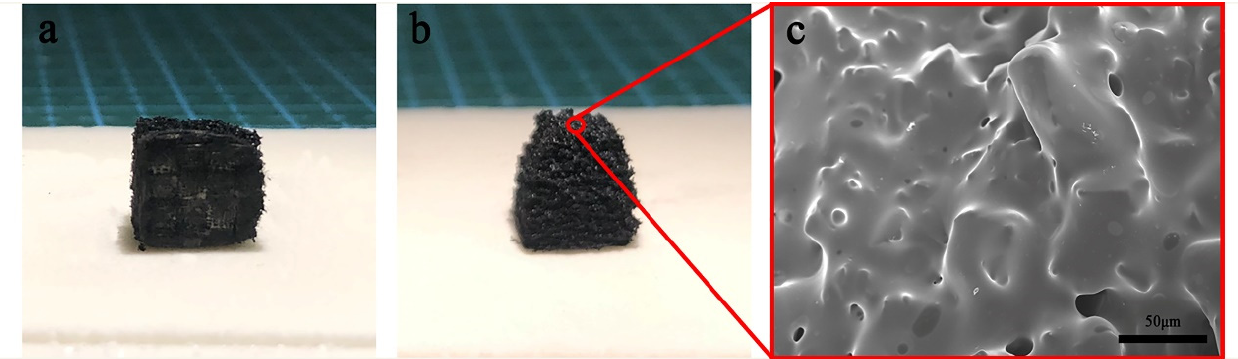
Figure 8. the picture of the SiBCN–phenolic/C composites oxidized 2 h at 1000 °C ( a , b ) and SEM image of the surface of the SiBCN–phenolic/C composites oxidized 2 h at 1000 °C ( c ).